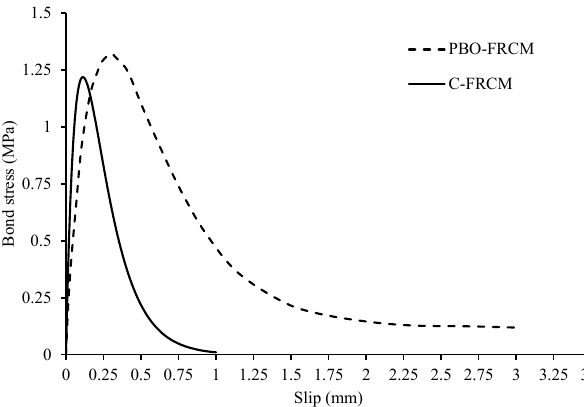
Figure 15. Bond-slip models adopted at the fabric–matrix interface data from [42,43].